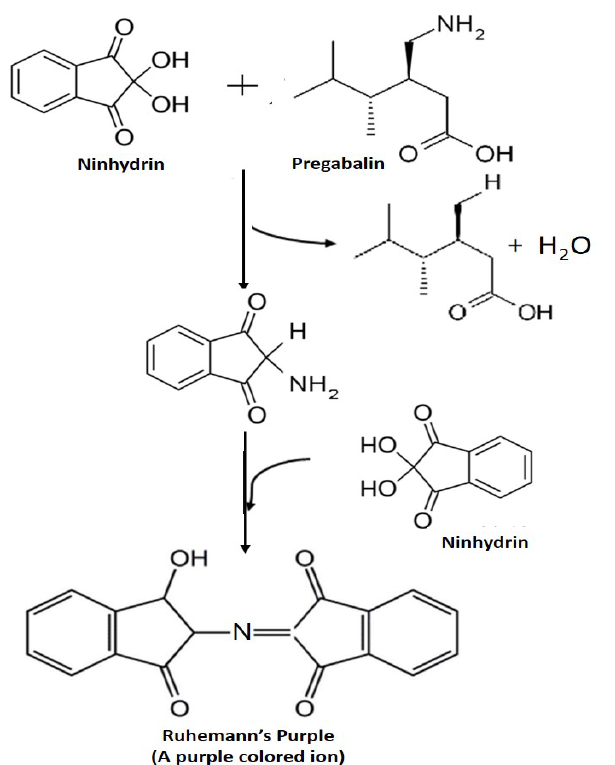
FIGURE 4 - Proposed reaction of pregabalin with ninhydrin at optimized